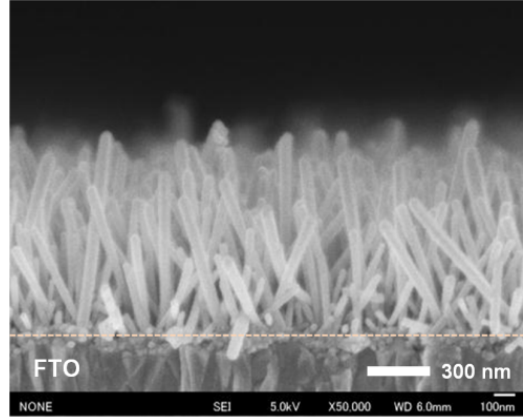
Figure 7. Cross-sectional FESEM image of ZnO NRs grown on 50 nm-thick AZO on the fluorine-doped SnO (FTO) coated glass substrate. The seed layer annealing temperature 2 is 350 °C.